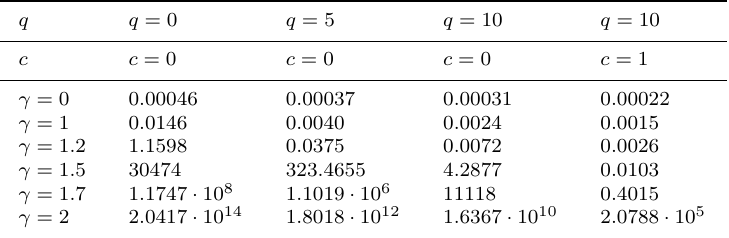
Table 5. The error of solution in the case q ( x,y ) = q (1 + cx )(1 + cy ), h = 1 / 160, τ = 1 / 2560, T = 1, a = 1 q q = 0 q = 5 q = 10 q = 10 c c = 0 c = 0 c = 0 c = 1 γ =